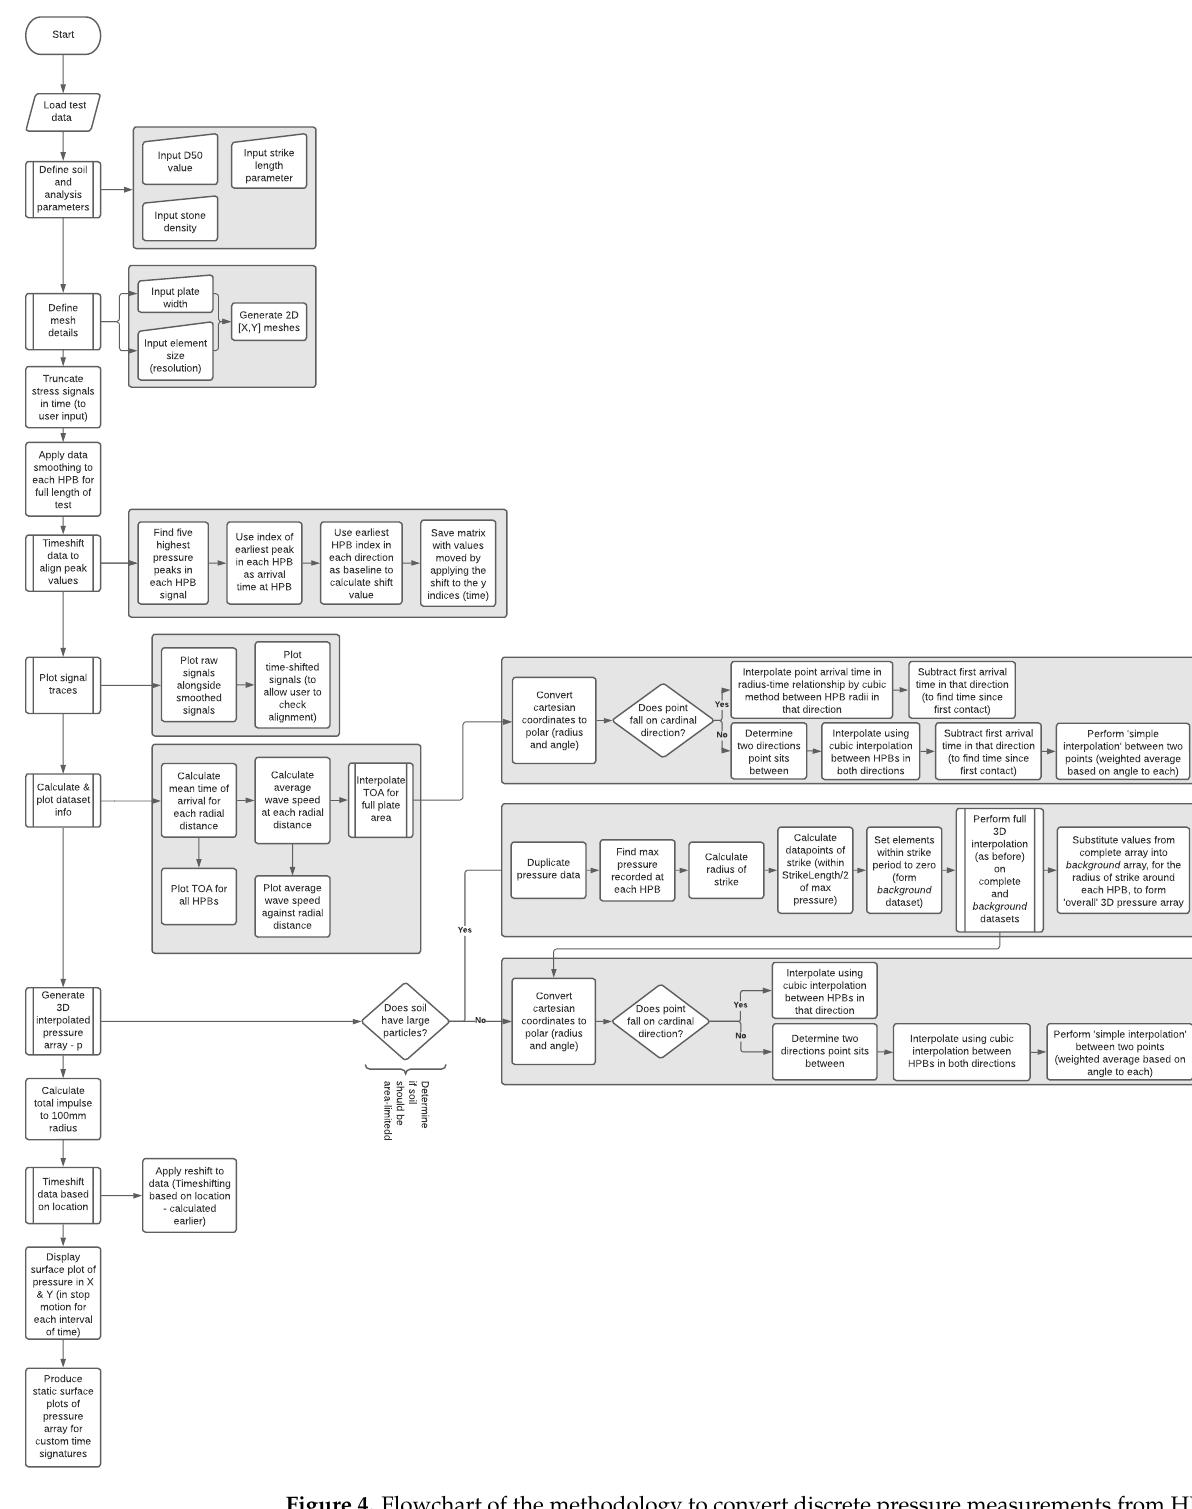
Figure 4. Flowchart of the methodology to convert discrete pressure measurements from HPBs to a full-plate